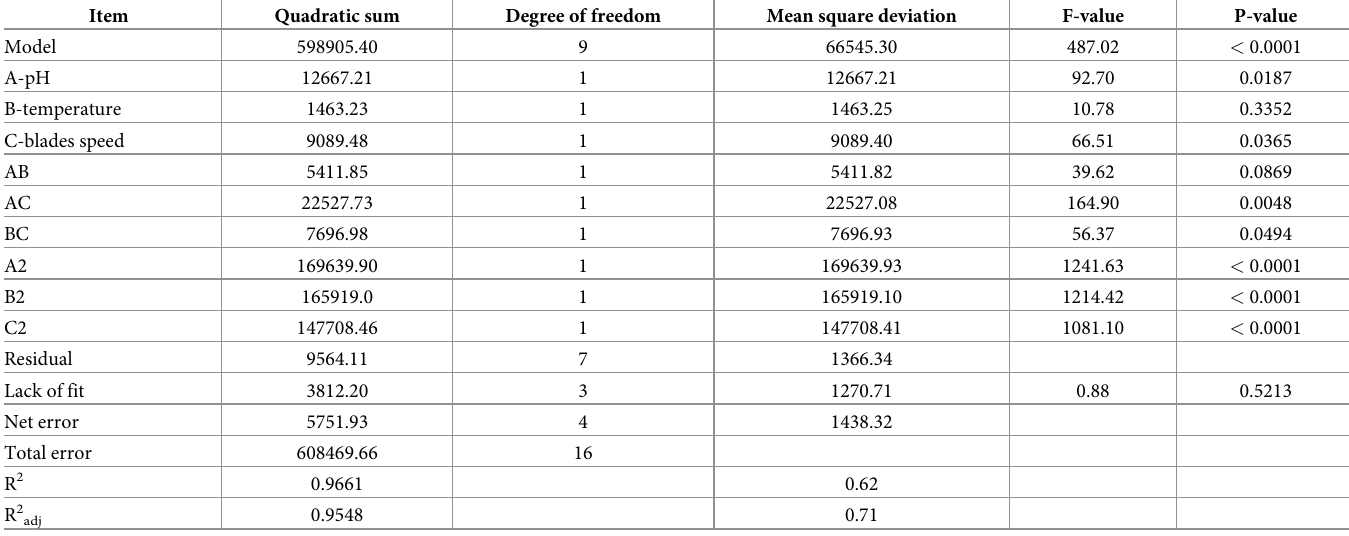
Table 7. Variance analysis of the quadratic model by the response surface test of fermentation